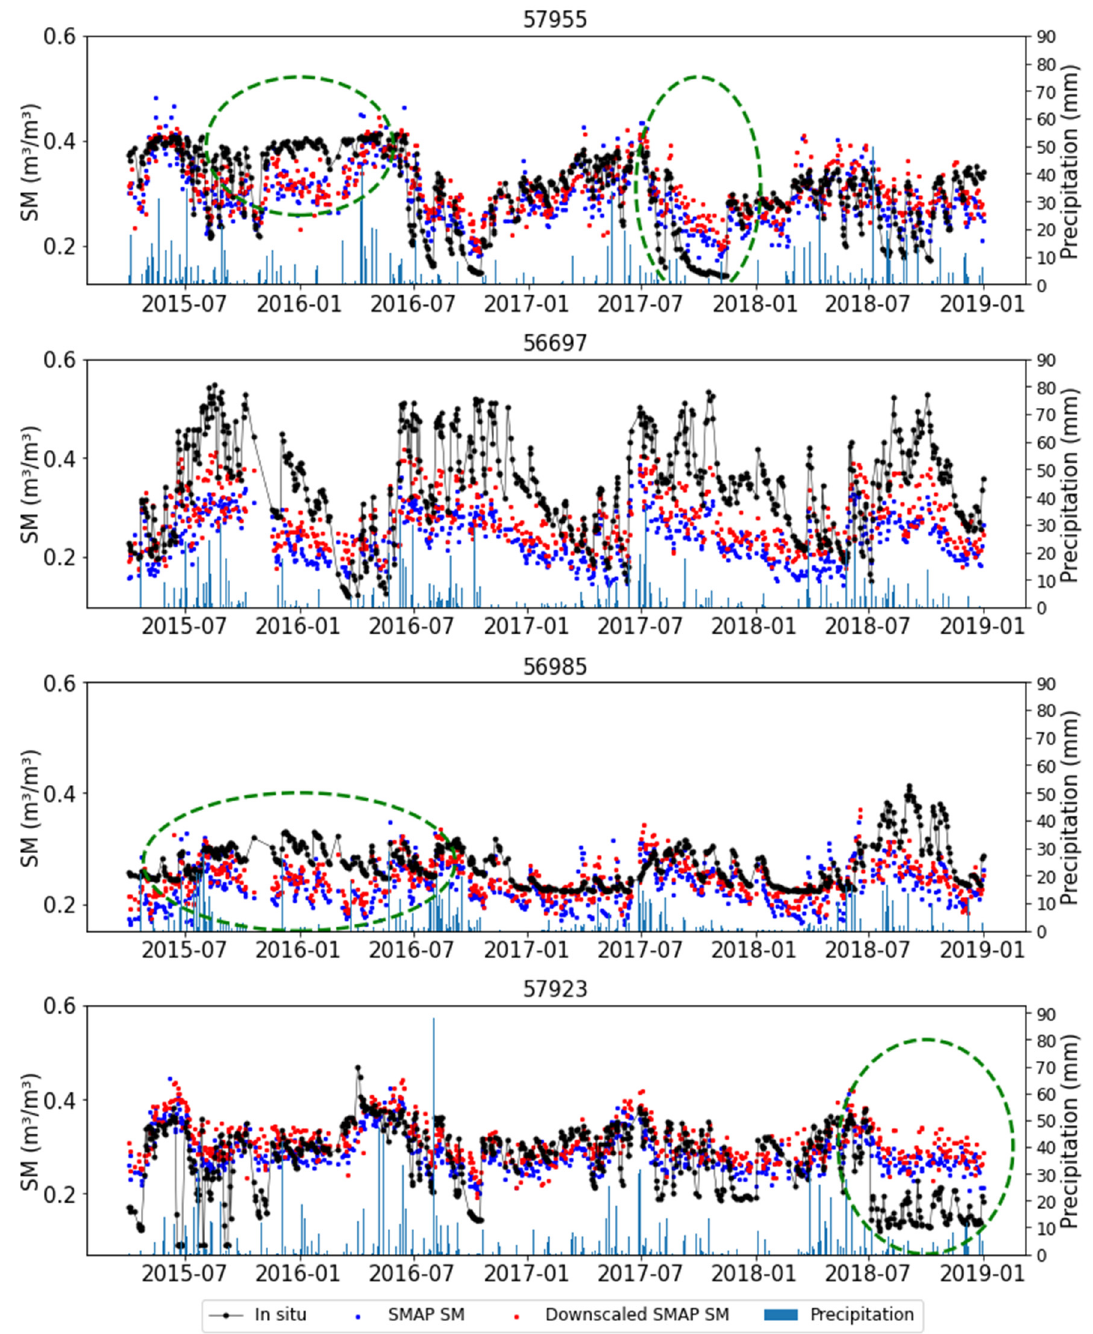
Figure 11. Time series of the original SMAP SM, the downscaled SM and the in situ SM at four